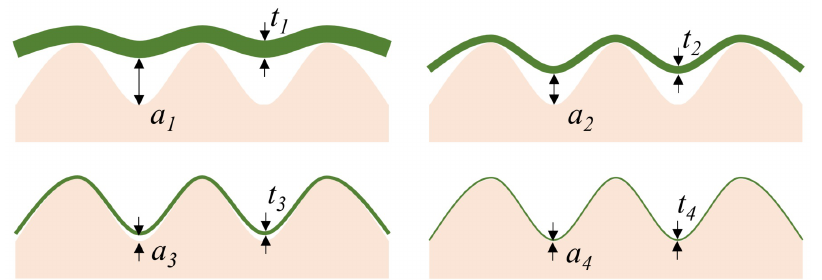
Figure 2. Reduction of the total film thickness reduces air gaps and improves the conformal contact between the film and the